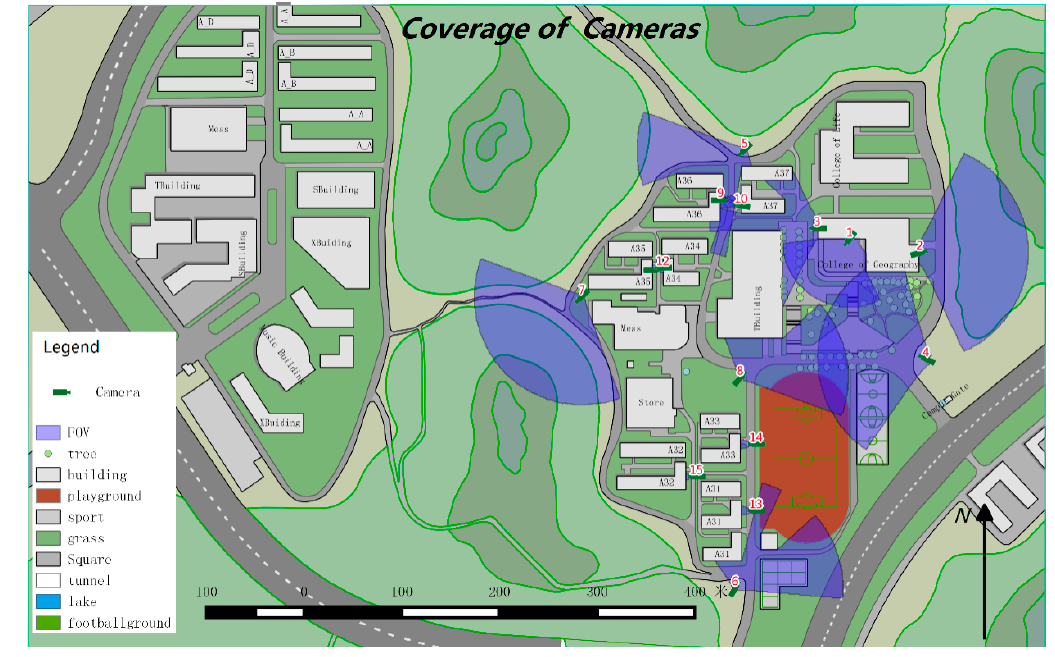
Figure 12. Cameras’ coverage in geographic environment. Table 2. Camera